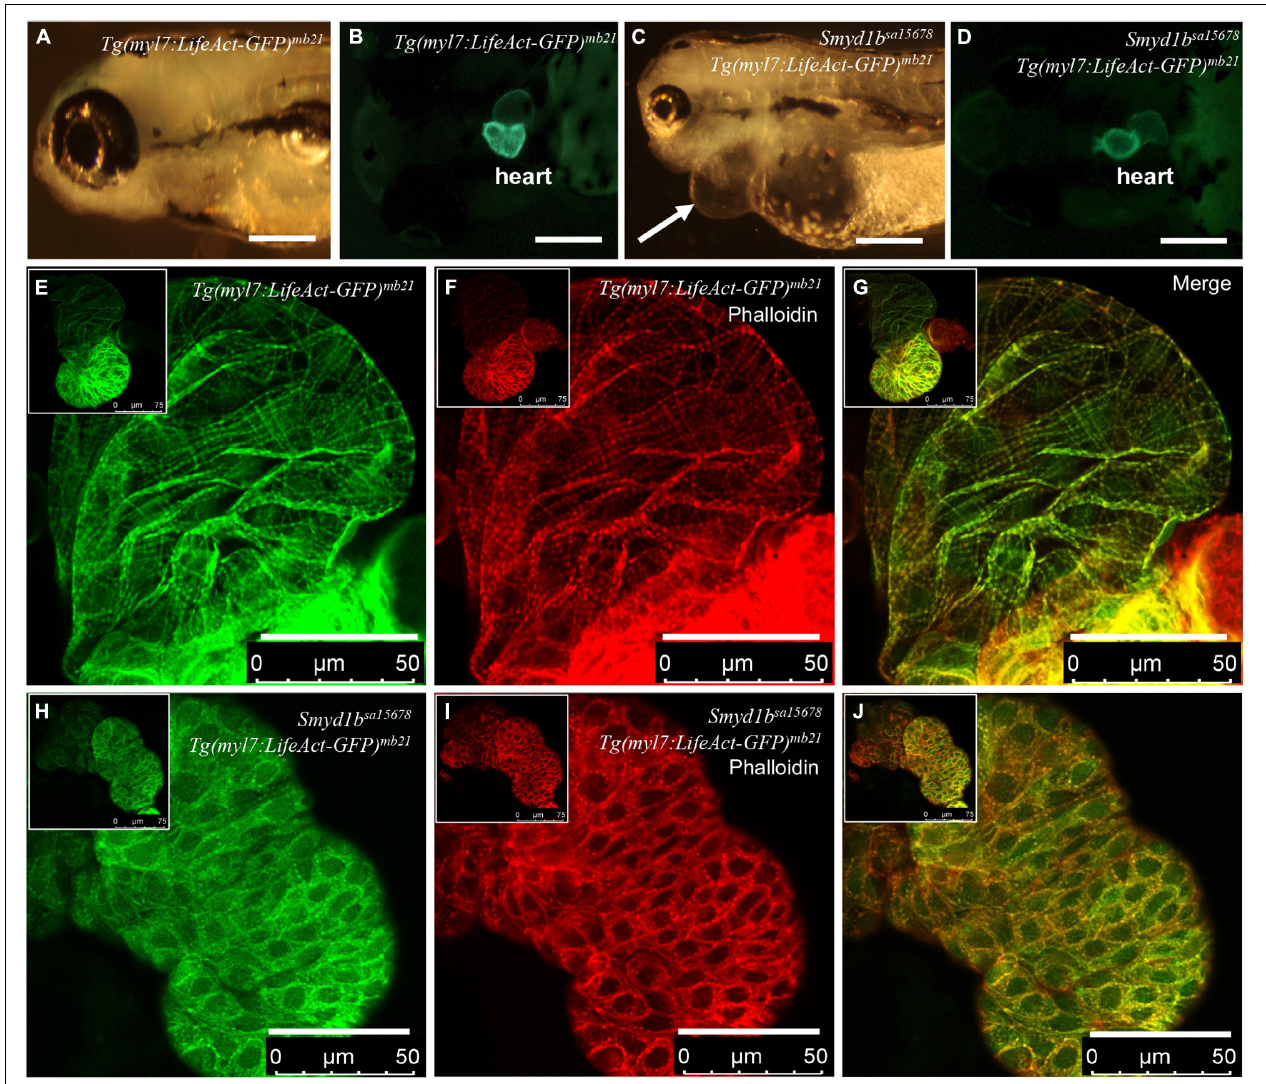
FIGURE 1 | Analysis of congenital cardiomyopathy in smyd1b sa 15678 mutant using Tg(myl7:Lifeact-GFP) transgenic zebrafish model. (A–D) Morphology and Lifeact-GFP expression in the heart region of WT Tg(myl7:Lifeact-GFP) mb 21 (A,B) , and smyd1b sa 15678 ; Tg(myl7:Lifeact-GFP) mb 21 mutant (C,D) transgenic larvae at 72 hpf. Pericardial edema is indicated by arrow in smyd1b sa 15678 ; Tg(myl7:Lifeact-GFP) mb 21 transgenic mutant larvae (C) . Scale bars: 250 µ m. (E–J) Actin think filaments in cardiomyocytes revealed by Lifeact-GFP (E,H) and phalloidin staining (F,I) in WT Tg(myl7:Lifeact-GFP) mb 21 (E–G) , and smyd1b sa 15678